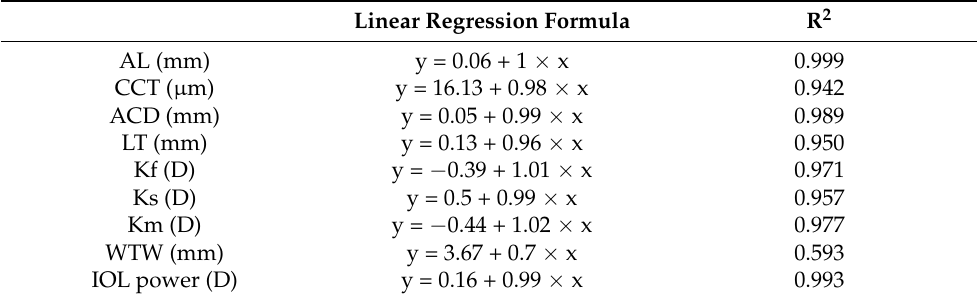
Table 3. The linear regression formulas and correlations for the anterior segment parameters in both devices.